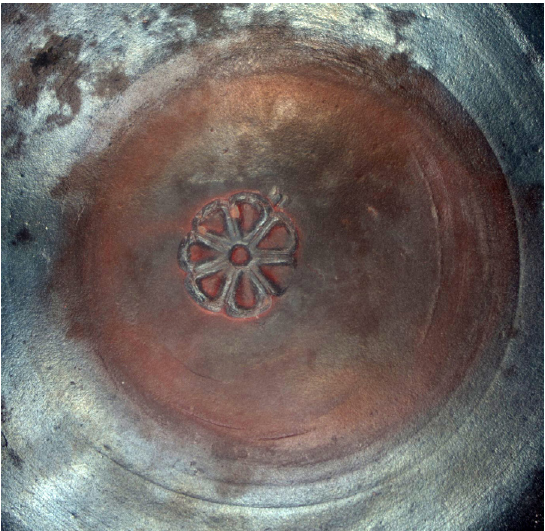
Figure 5. Black gloss bowl from the Capistello shipwreck showing a discolouration in the center (reddish brown instead of black), due to stacking in the kiln. Photo by L. Opgenhaffen.